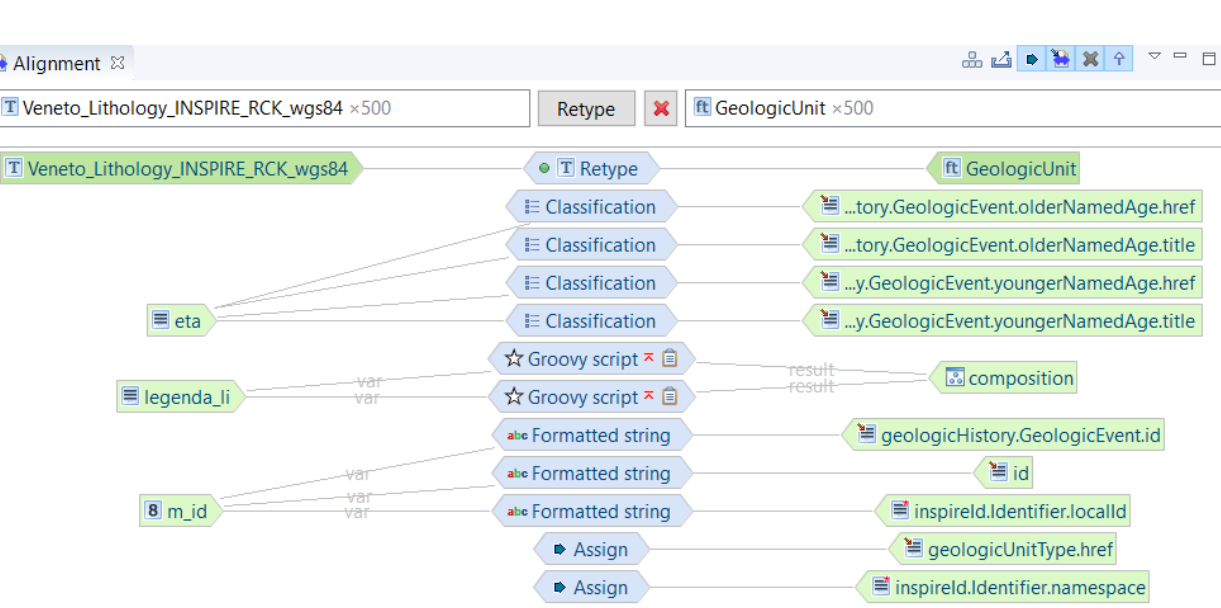
Figure 5. Visualization of INSPIRE data alignment within Hale Studio. The left side shows the source Veneto Lithology shape file, the right side shows the target GeologicUnit feature type within the INSPIRE Geology schema, and the centre shows the classification method used to align the